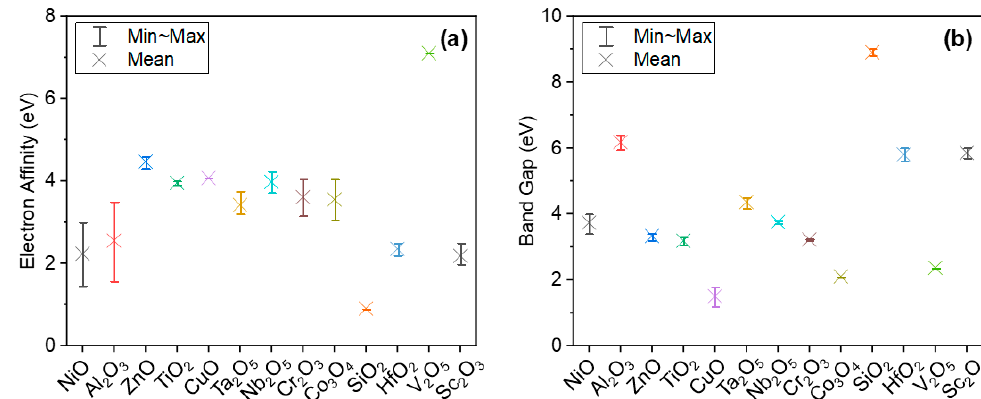
Figure 3. ( a ) Electron affinity and ( b ) band gap of typical oxides for MIM diodes. Full details are provided in Table 1.